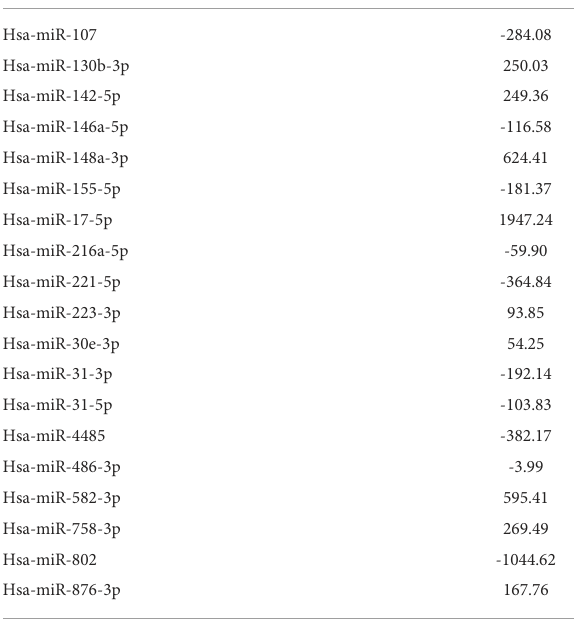
TABLE 3 The coef fi cient of 19 miRNAs in